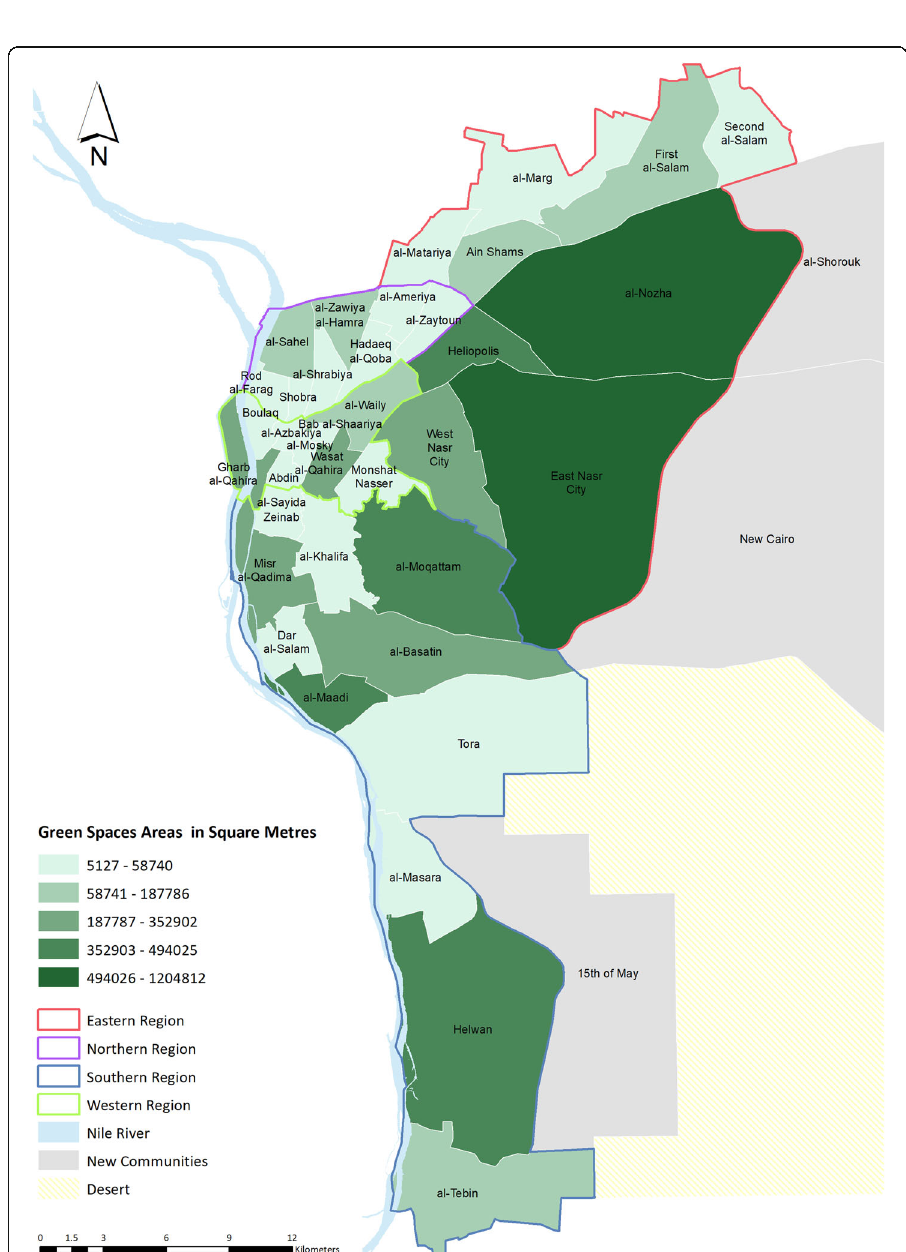
Fig. 3 Distribution of green spaces in Cairo based on 2020 data